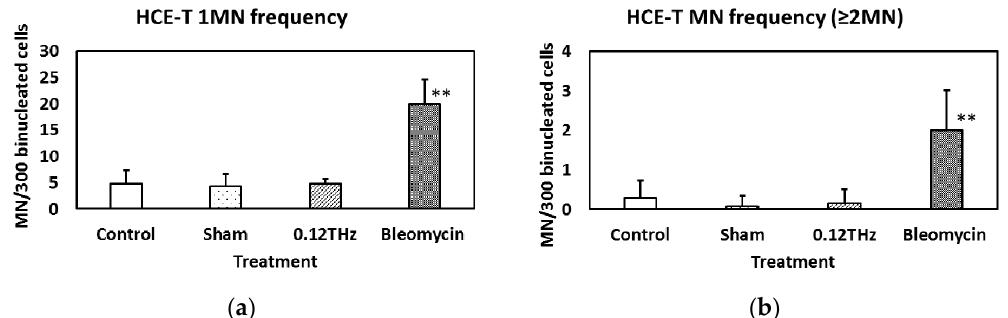
Figure 2. ( a ) Single and ( b ) ≥ 2 micronucleus (MN) frequency in human corneal epithelial (HCE-T) cells exposed to 0.12 THz radiation for 24 h. The positive control was treatment with bleomycin (10 µ g/mL). Data are presented as the mean ± SD from six independent experiments. Asterisks indicate p < 0.01. f = 0.1, (1 −β ) = 0.872.